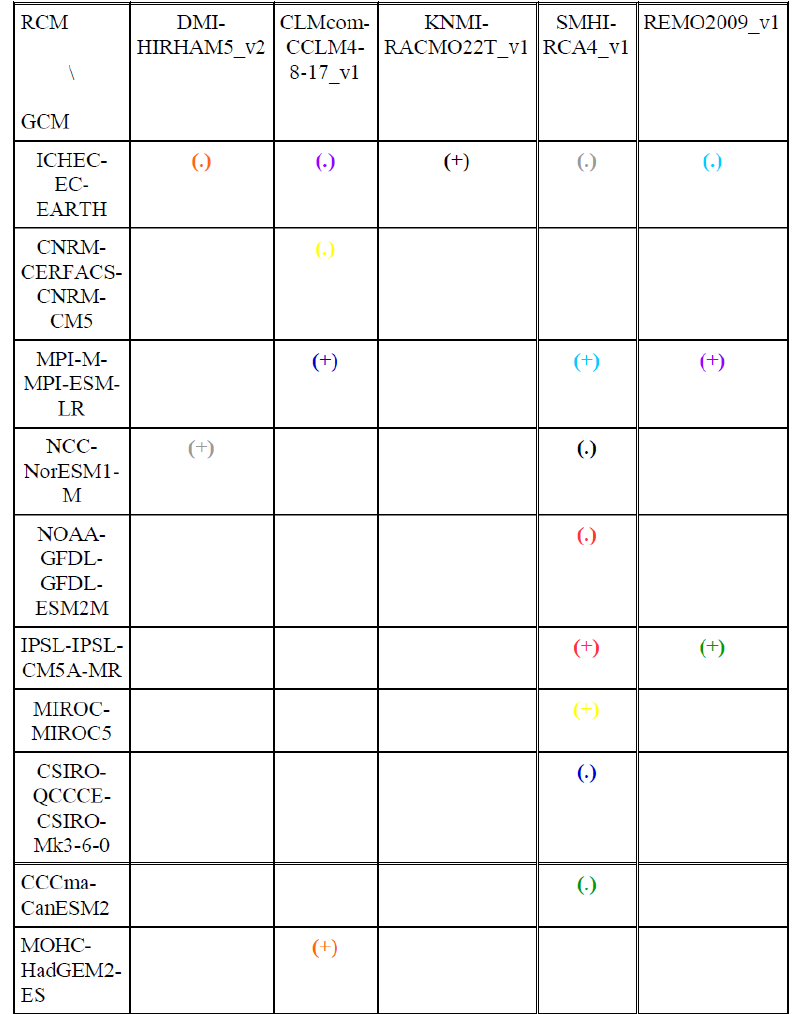
Table 1. Summary of 18 simulations (GCM/RCM chains) taken from the CORDEX-Africa data. In this ensemble, 5 RCMs are used to downscale 10 GCMs. Each experiment comprises one historical and one scenario (RCP8.5) run, spanning the periods 1981–2005 and 2006– 2099 respectively. The horizontal resolution of all simulations is 0.5 ◦ in both latitude and longitude. The colors and symbols refer to Figs. 3, 4, and